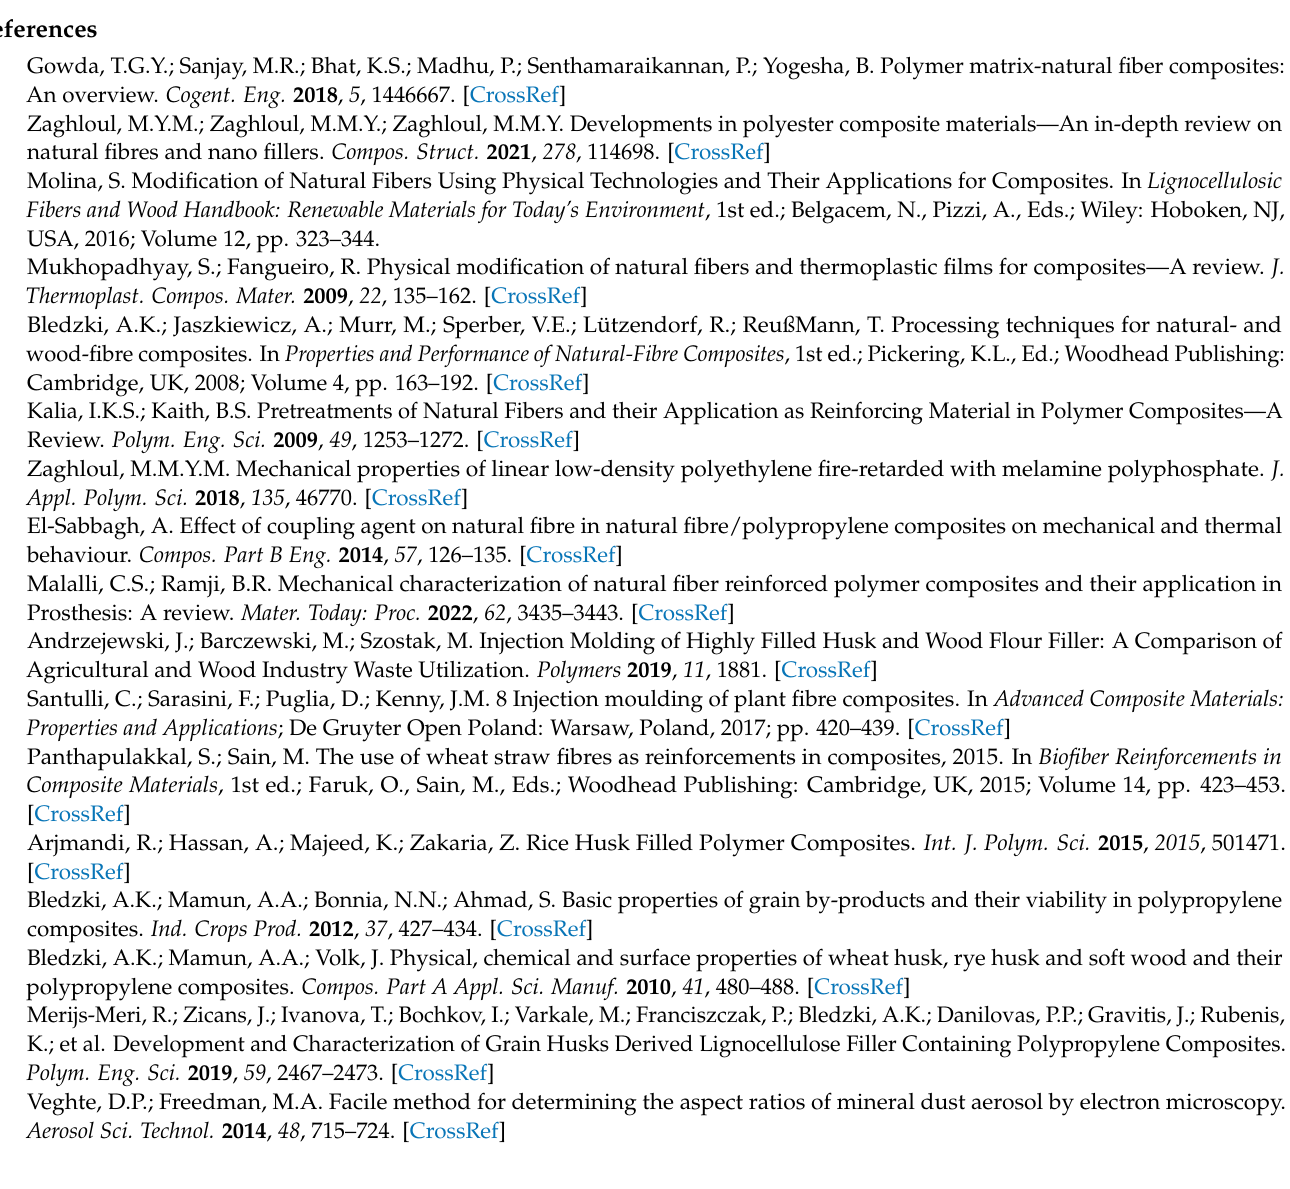
M, Figure S4: TGA thermograms of PP, PPgMA and its composites with SH, C, and M, Figure